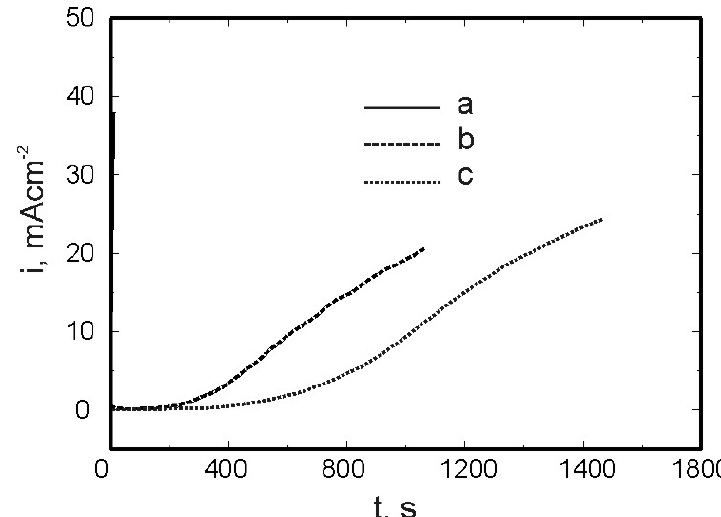
SO + 0.5 mol dm -3 KCl with pH=4 at E=0.05 V: 2 4 SO film and (c) sample covered with 4-ABA film. 2 4